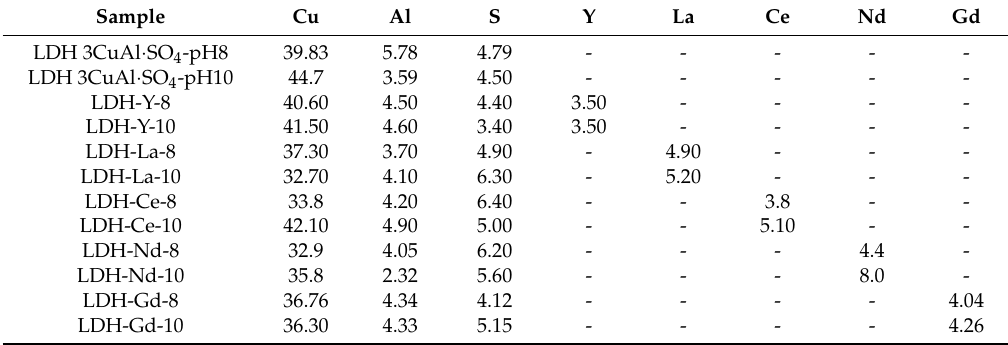
Table 1. Chemical composition of the synthetic samples. The values are expressed in wt %. Sample Cu LDH 3CuAl · SO 4 -pH8